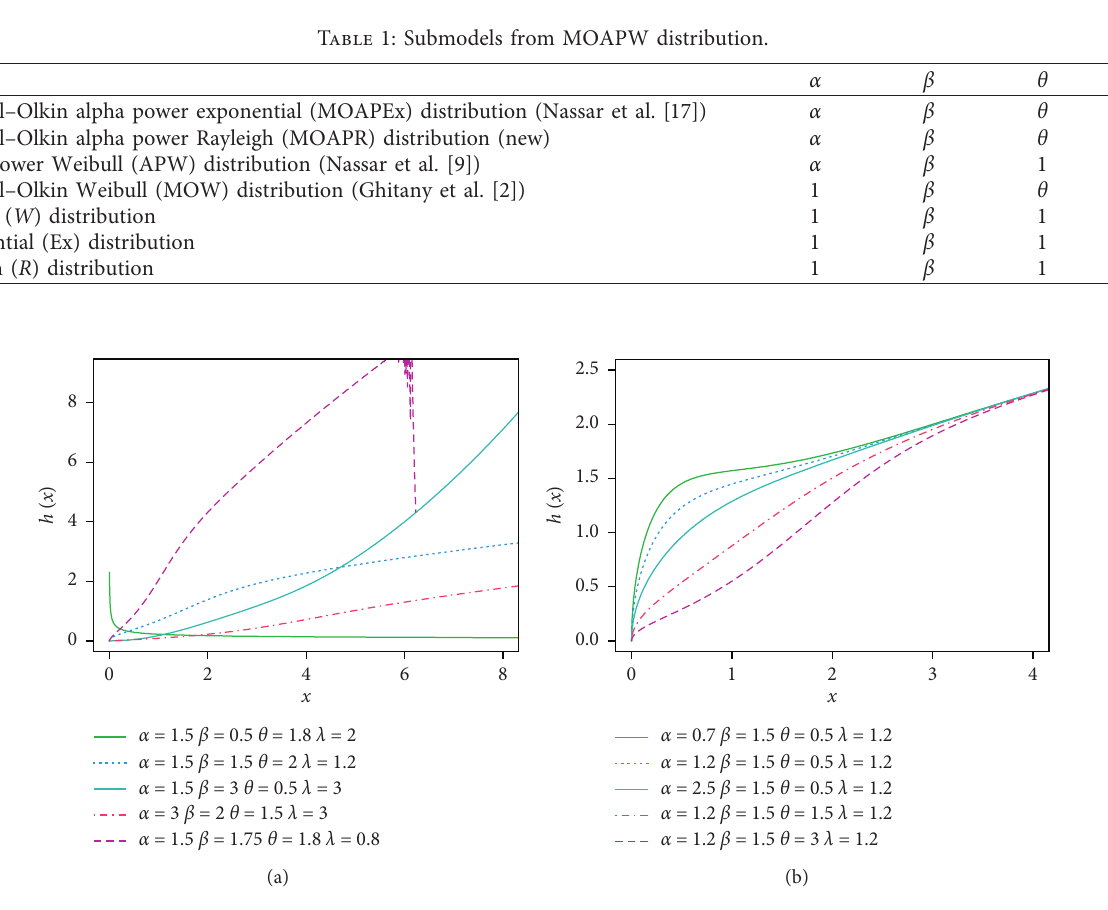
Figure 2: The hazard function of MOAPW under different parameters’